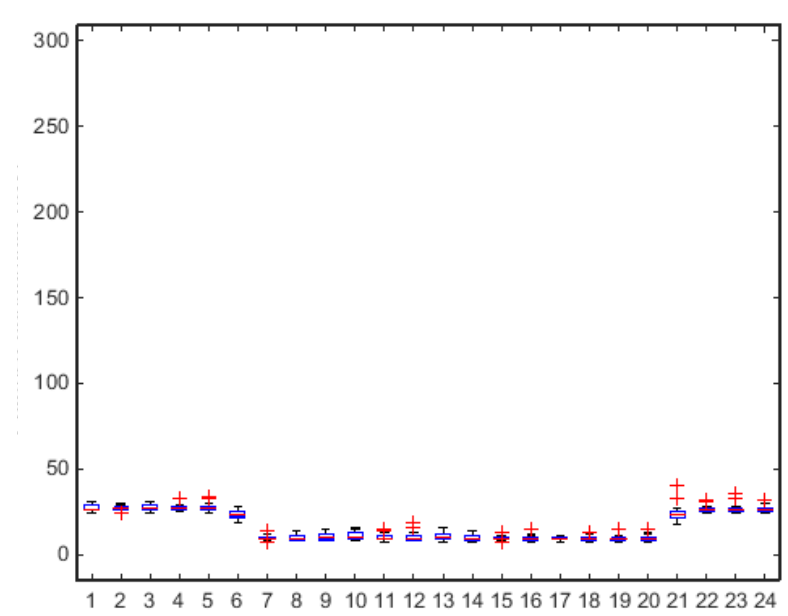
Figure 9. Pilot system: School (Palo del Colle). Box plots of weekend days power consumption. The x-axis reports day ours, while y-axis indicates power consumption (kW).